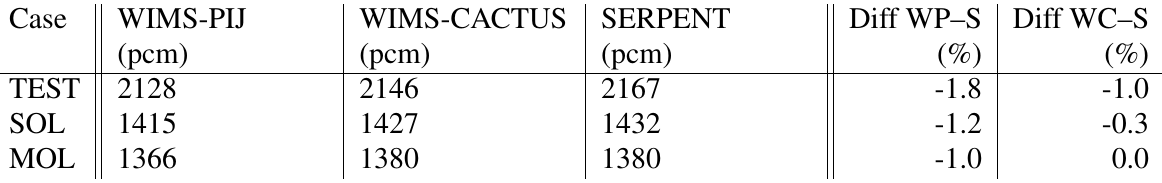
Table II: Nitrogen Worths Comparisons with WIMS and SERPENT. All SERPENT results are converged to within 5